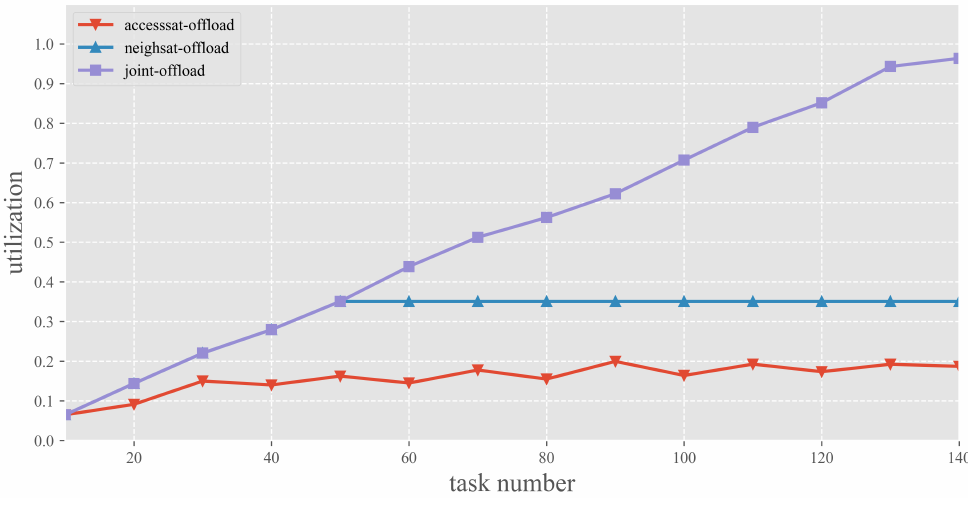
Figure 9. Satellite computing resource utilization varies with number of tasks in constellation 2 with 72